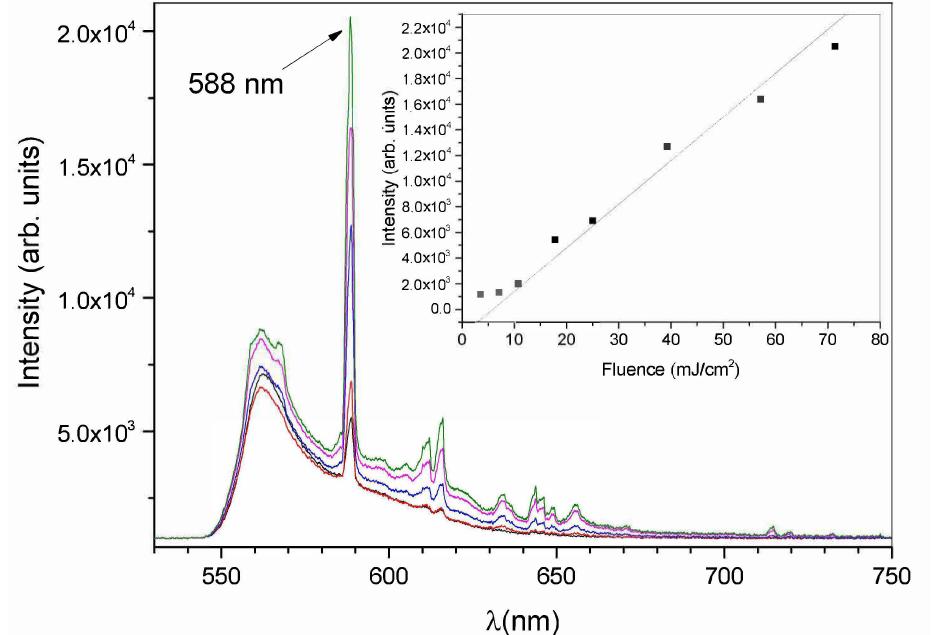
Figure 6. Lasing from the free-standing DFB structure for different values of the impinging energy. The energy values are reported in the inset. The laser threshold is around ≈ 3.5 mJ/cm 2